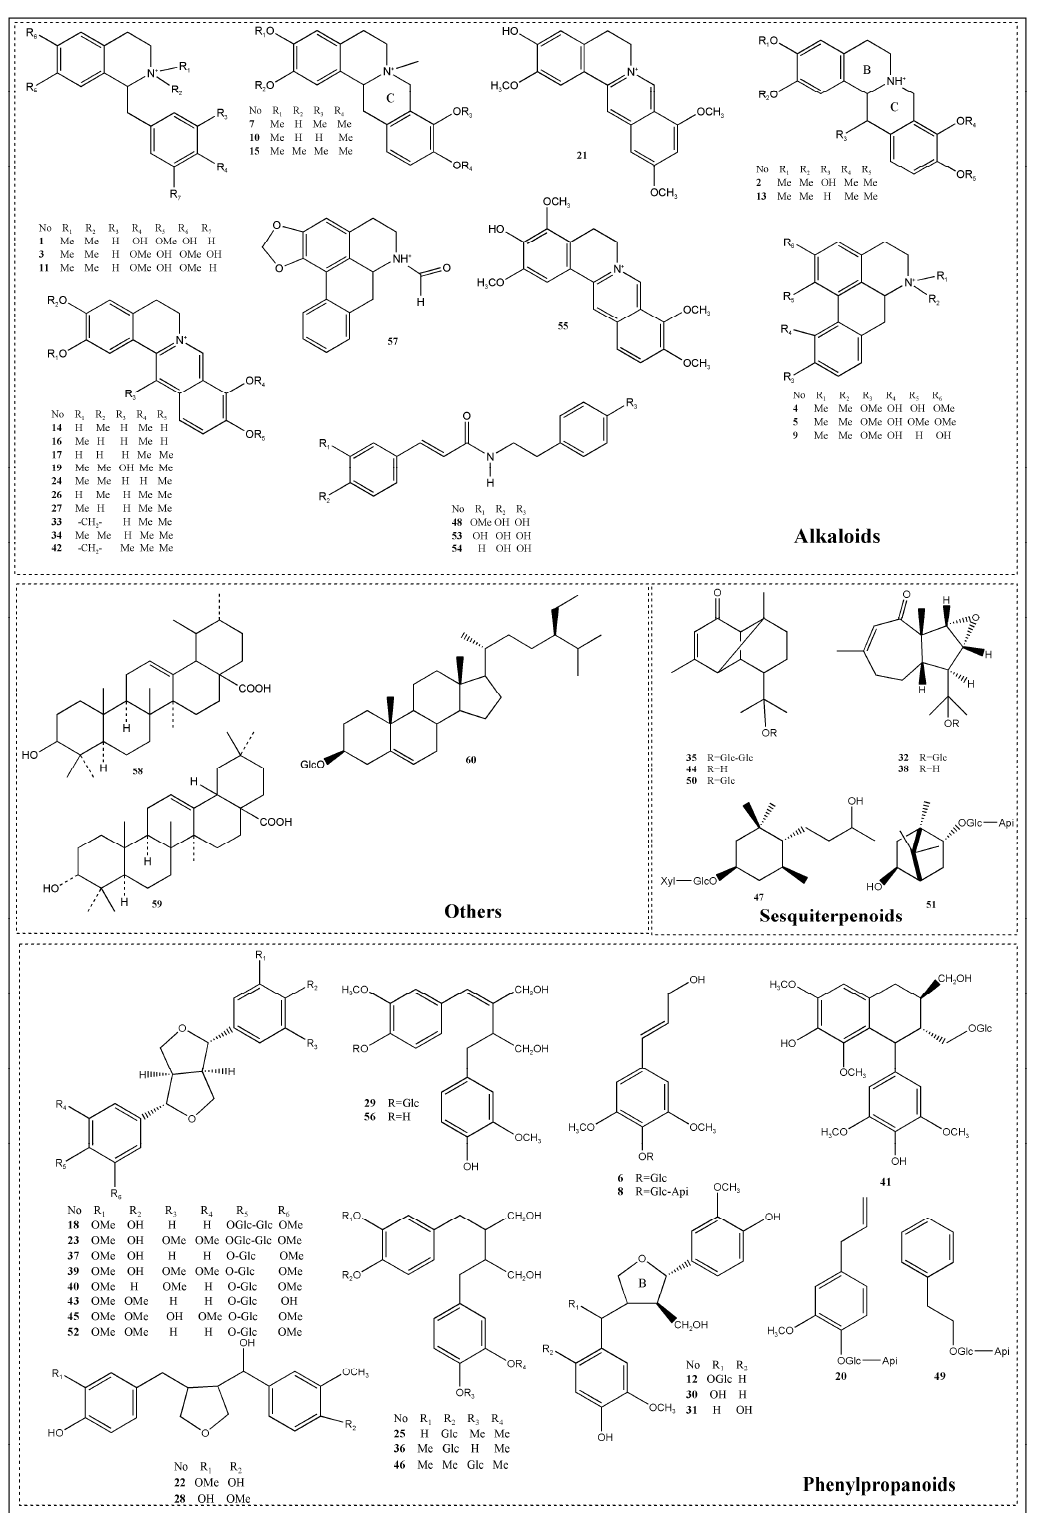
Figure 1. The structures of compounds identified in T. sinensis.